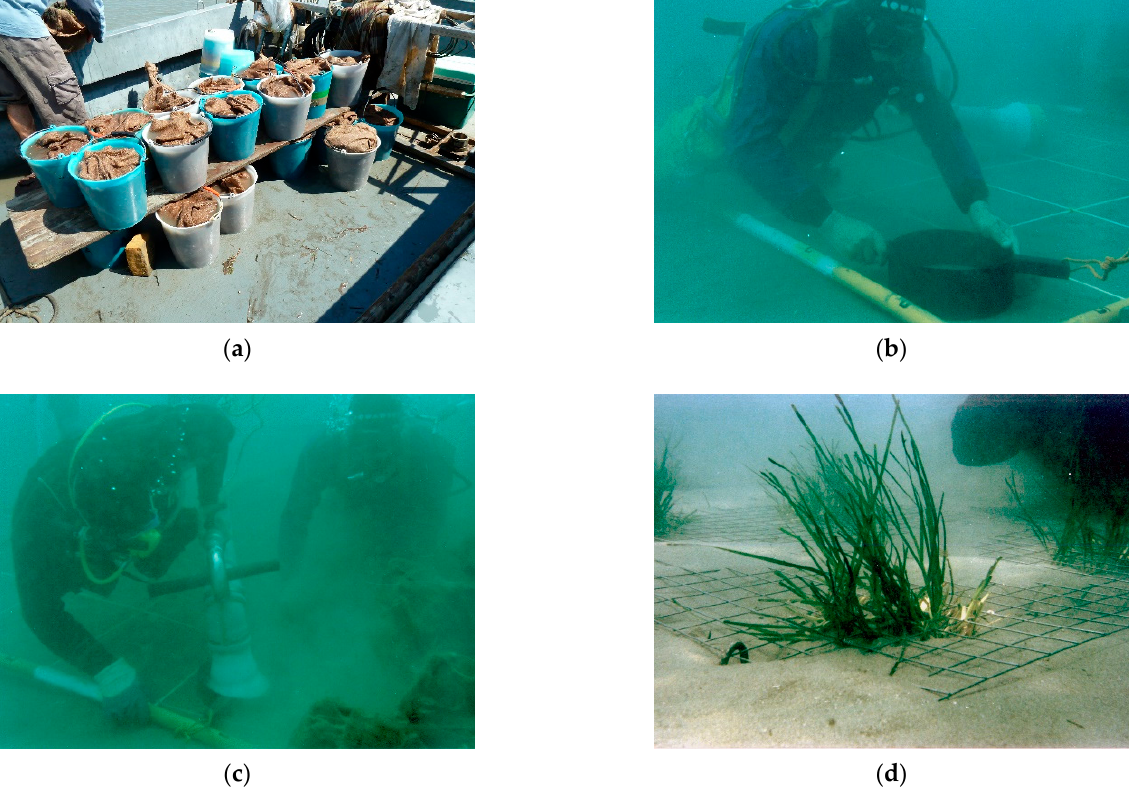
Figure 7. Manual transplantations: ( a ) temporary storage of sods on boat, ( b , c ) transfer and deposition of the sods in the transplantation site and ( d ) sods protected with 10 cm mesh metal nets.